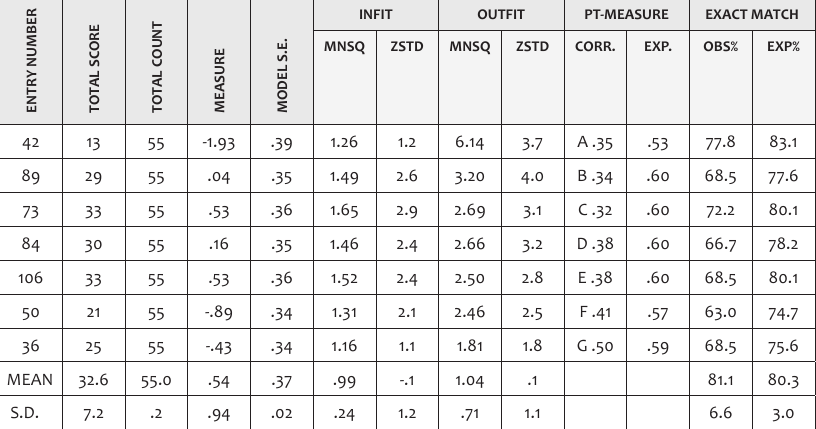
Table 3: Person statistics: misfit